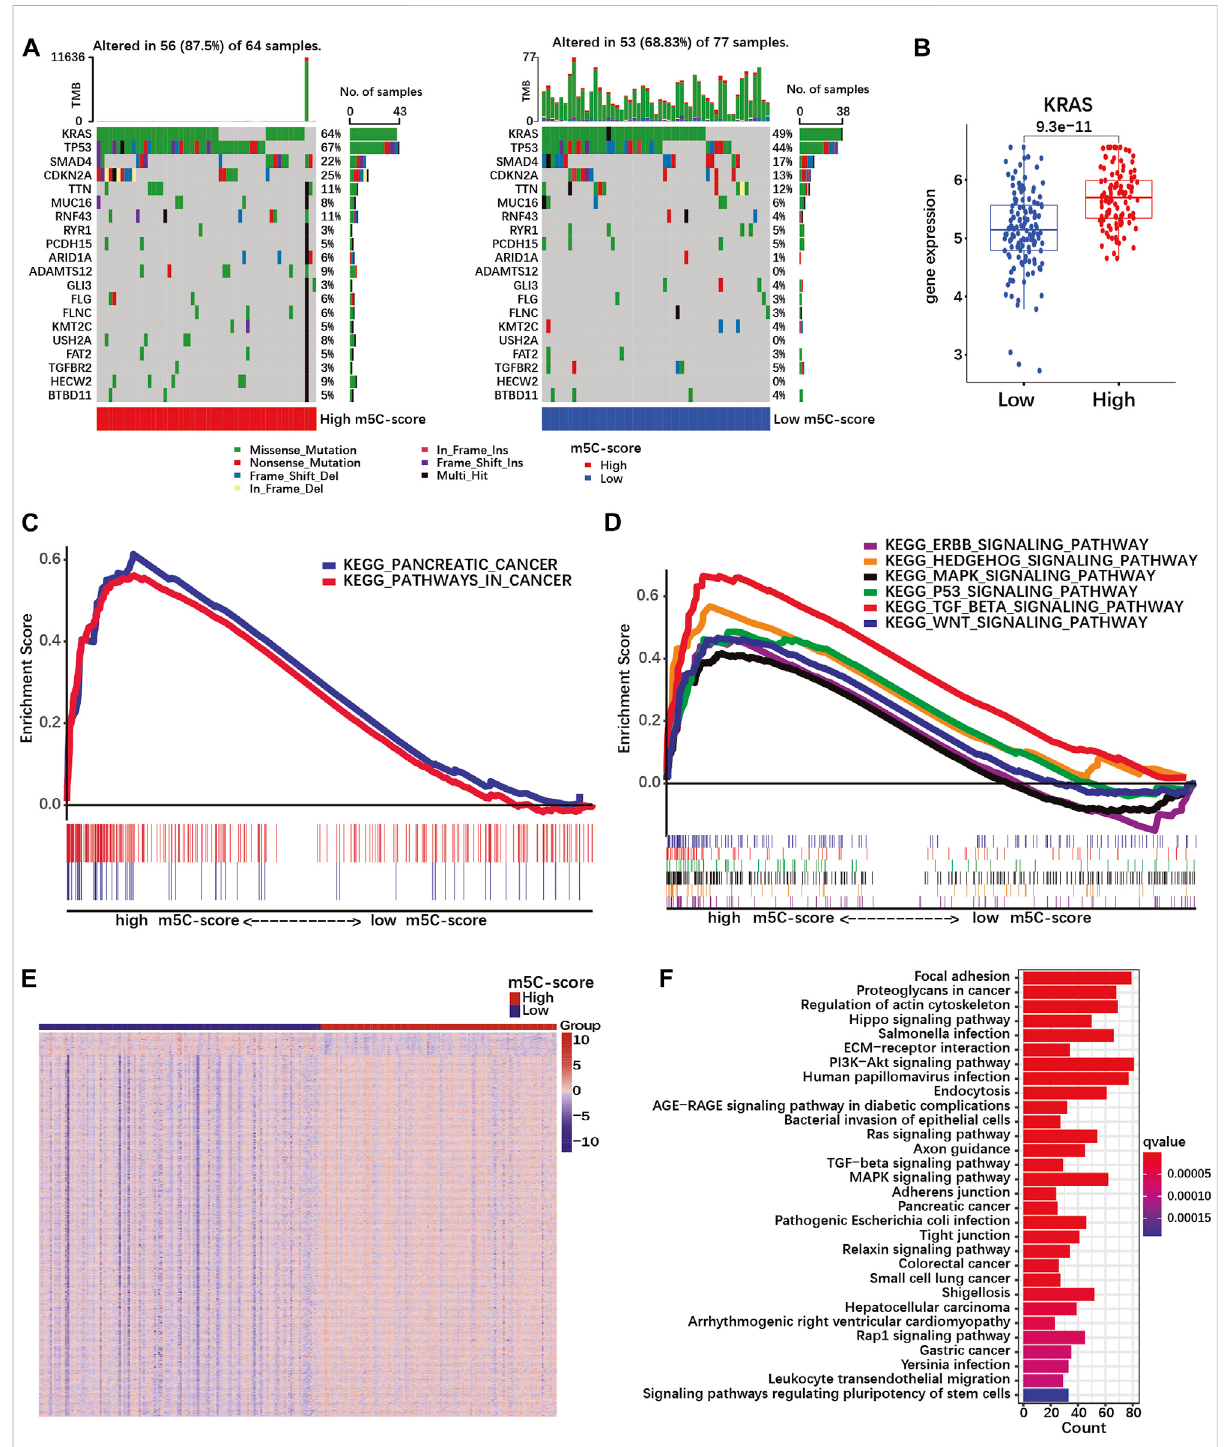
FIGURE 5 Ahighm5C-scoreisassociatedwithincreasedmutationrateandexpressionofPDAC-relatedgenesandpathways. (A) Somaticmutationstatus inhigh-andlow-m5C-scoregroupsintheTCGA-PAADcohort.Theupperbarrepresentstumormutationburden(TMB),therightbarthenumberof PDACpatientwithmutationforeachofthe20mostfrequentlymutatedgenesinPDAC,andthebarbelowhigh-andlow-m5C-scoregrouppatients. (B) KRASexpressioninhigh-andlow-m5C-scoretumorsfromtheTCGA-PAAD+GSE57495cohort. (C,D) Genesetenrichmentanalysis(GSEA) between high- and low-m5C-score groups in the TCGA-PAAD cohort. (E) Heatmap of DEGs between high- and low-m5C-score groups. Columns represent patients and rows DEGs between high- and low-m5C-score groups. (F) KEGG pathway analyses for genes differentially expressed between high- and low-m5C-score